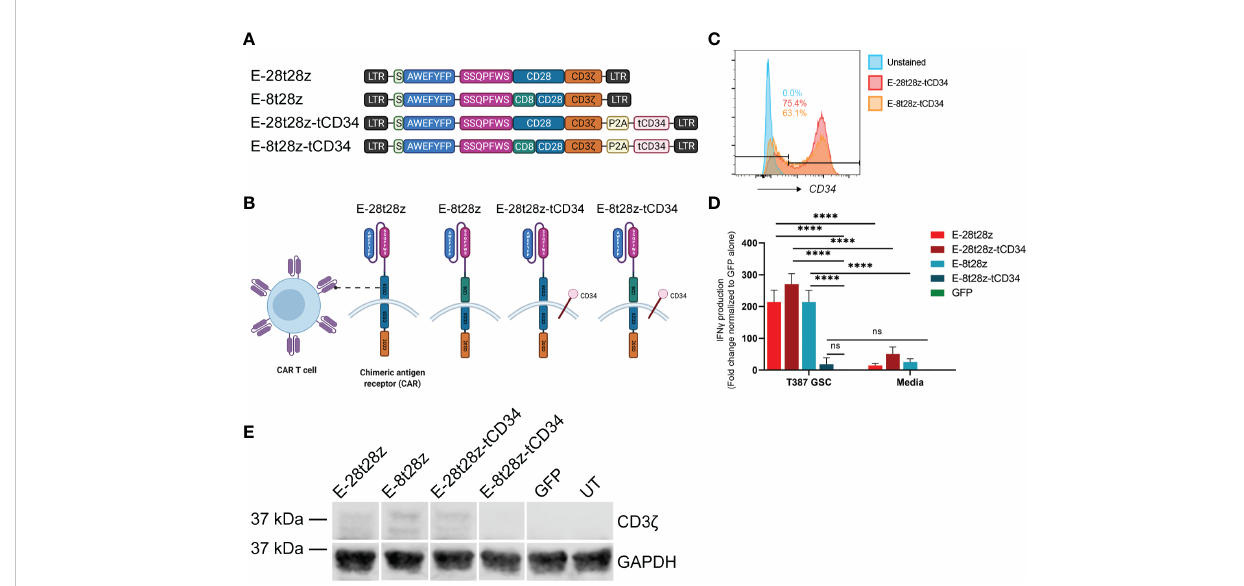
FIGURE 4 Dual peptide CAR-T cell design. (A) Diagram of the CAR construct designs. The E-28t28z and E-8t28z constructs use CD28 and CD8 as the hinge/ transmembrane domains respectively, while both constructs employed CD28 for the co-stimulatory domain. The E-28t28z-tCD34 and E-8t28z- tCD34 constructs are identical to the E-28t28z and E-8t28z constructs but feature co-expression of truncated CD34 as an extracellular marker. (B) Diagram of a CAR-T cell with the different dual peptide-based constructs as the antigen-recognition domain. (C) CD34+ expression analysis by fl ow cytometry allows for a built-in quanti fi cation of transduction ef fi ciency. (D) ELISA results displaying IFN-gamma secretion from CAR- or mock- transduced (GFP) T cells co-cultured overnight against T387 GSCs or cell-free media, **** = p < 0.0001. Values shown in the bar chart represent the average of two independent experiments. (E) CD3 z western blotting with GAPDH as a housekeeping gene, used for additional support to con fi rm the presence or lack of the CAR following transduction. LTR, Long terminal repeat; S, signal peptide; P2A, Porcine teschovirus-1 2A self-cleaving peptide; tCD34, Truncated